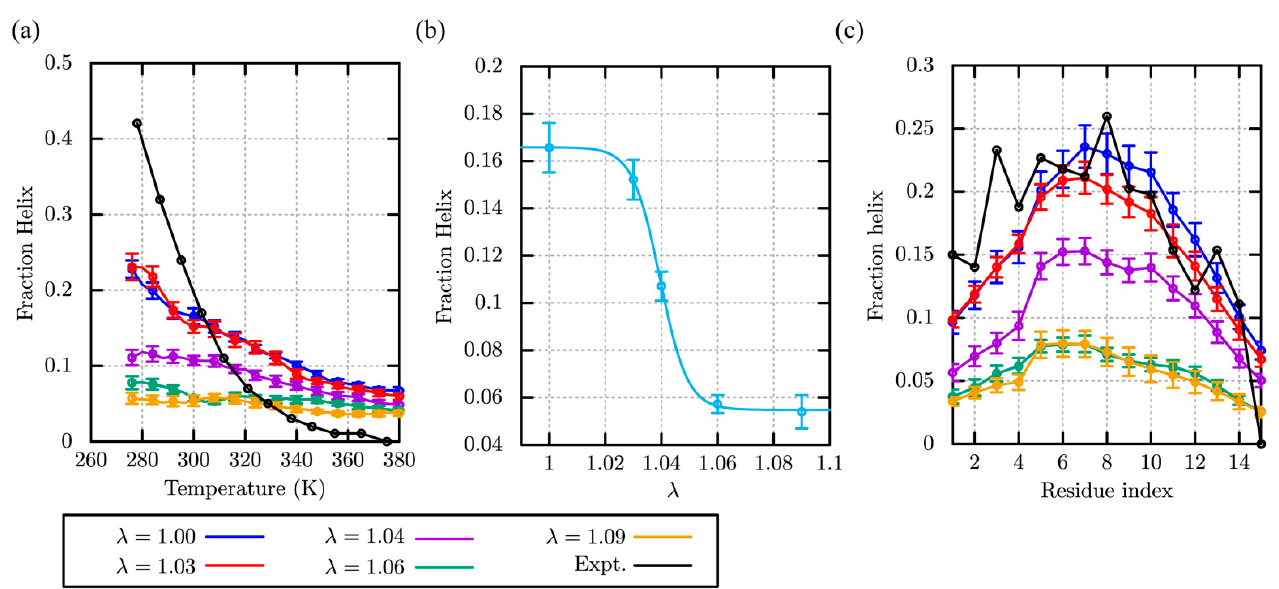
Figure 1. The 𝛼 -helicity of (AAQAA) 3 using a different scaling parameter, λ . ( a ) Temperature dependency of the fraction of helix, ( b ) the 𝜆 -dependency of the fraction of helix at 300 K, ( c ) the fraction of 𝛼 -helix in each residue at 300 K.